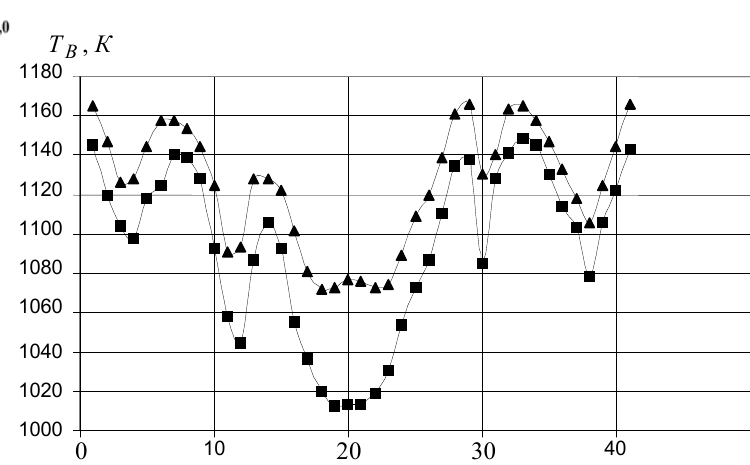
Fig 7. Distribution of temperature along outside ( ) and internal ( ) contours of the cooled nozzle